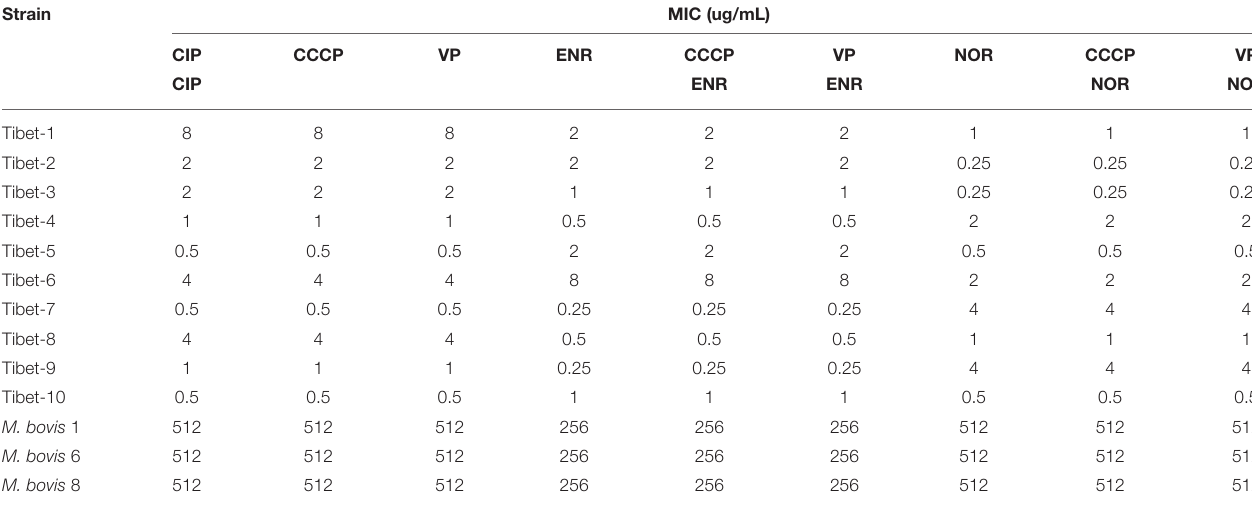
TABLE 7 | The MIC effects of fluoroquinolones by using CCCP and VP. Strain